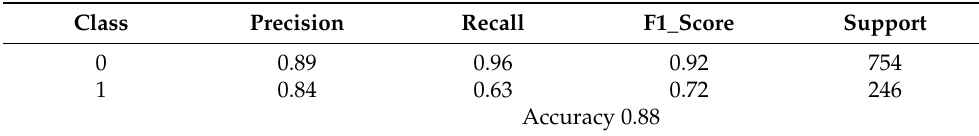
Table 8. Classification Report.